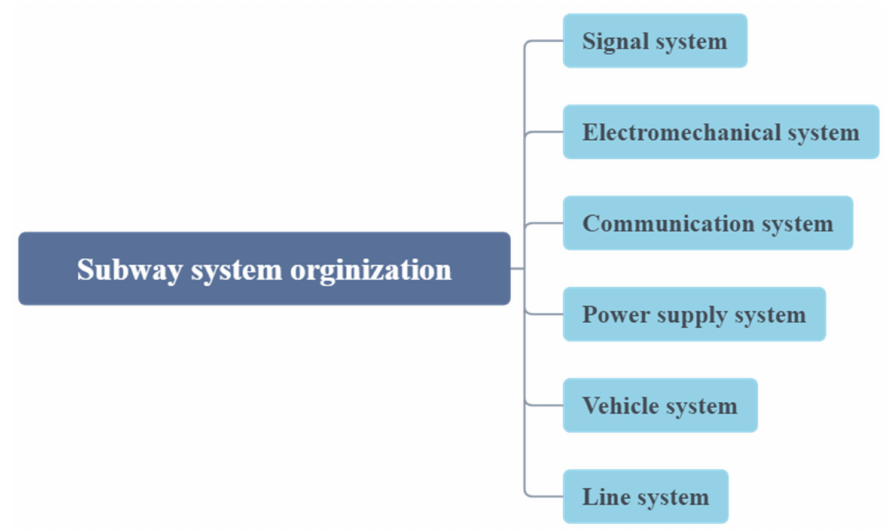
Figure 7. The structure of the subway system.